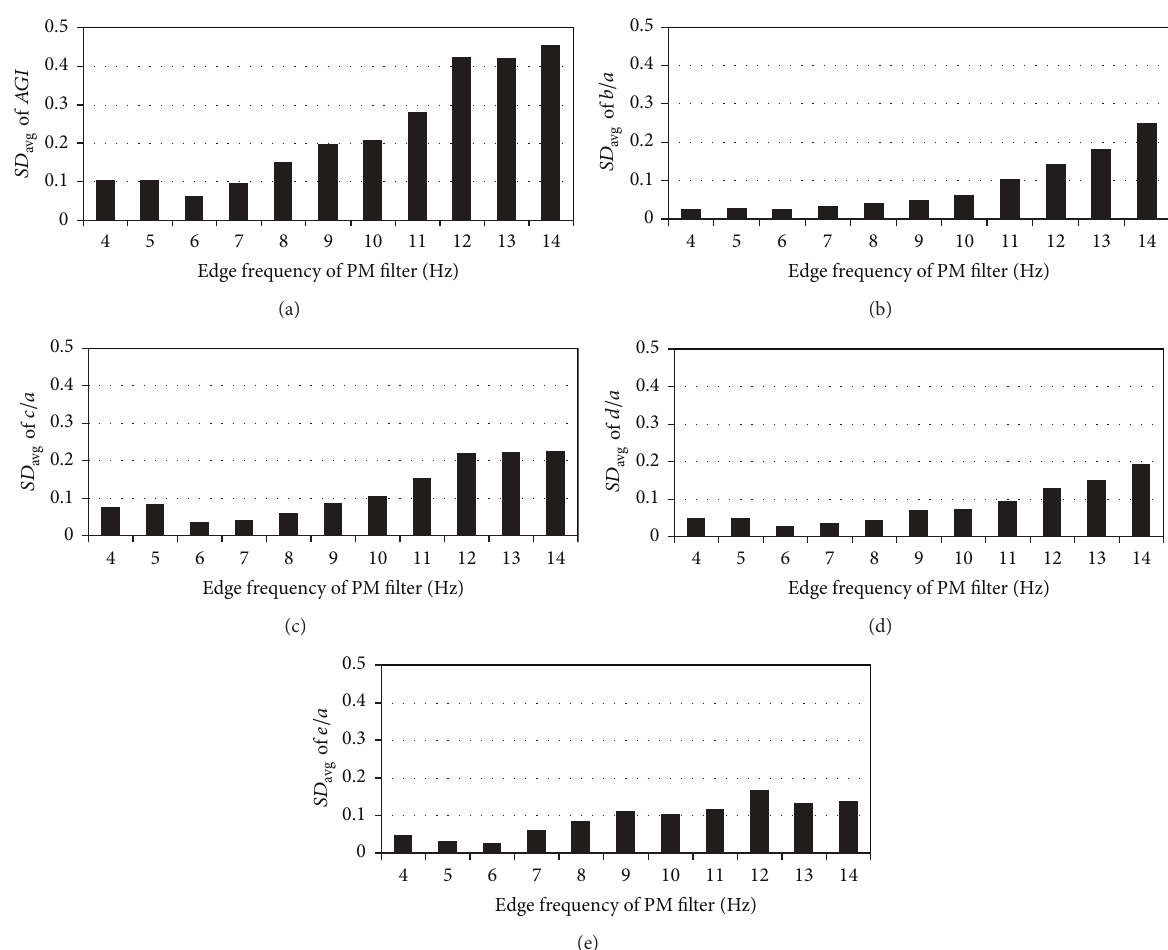
Figure 5: The average standard deviations ( 𝑆𝐷 ) of AGI and normalized amplitudes at different edge frequencies for 21 healthy subjects. avg (a) AGI s at different edge frequencies; (b) normalized amplitudes b / a at different edge frequencies; (c) normalized amplitudes c / a at different edge frequencies; (d) normalized amplitudes d / a at different edge frequencies; (e) normalized amplitudes e / a at different edge frequencies.